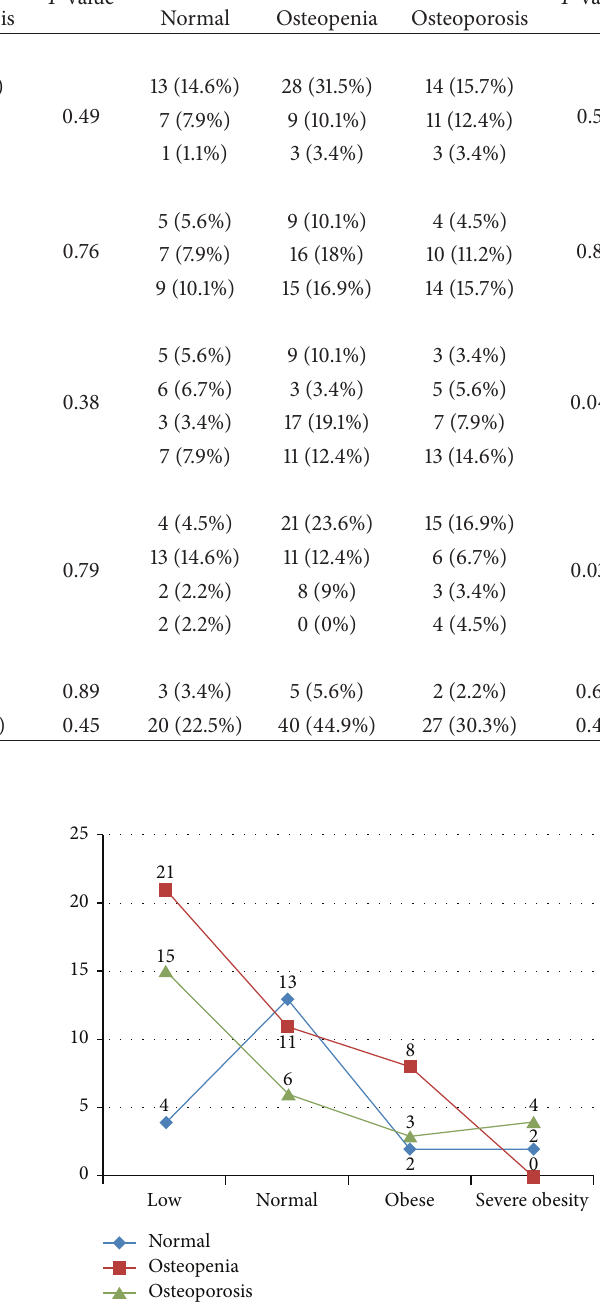
Figure 2: Interaction between osteoporosis in the femoral neck and patients’